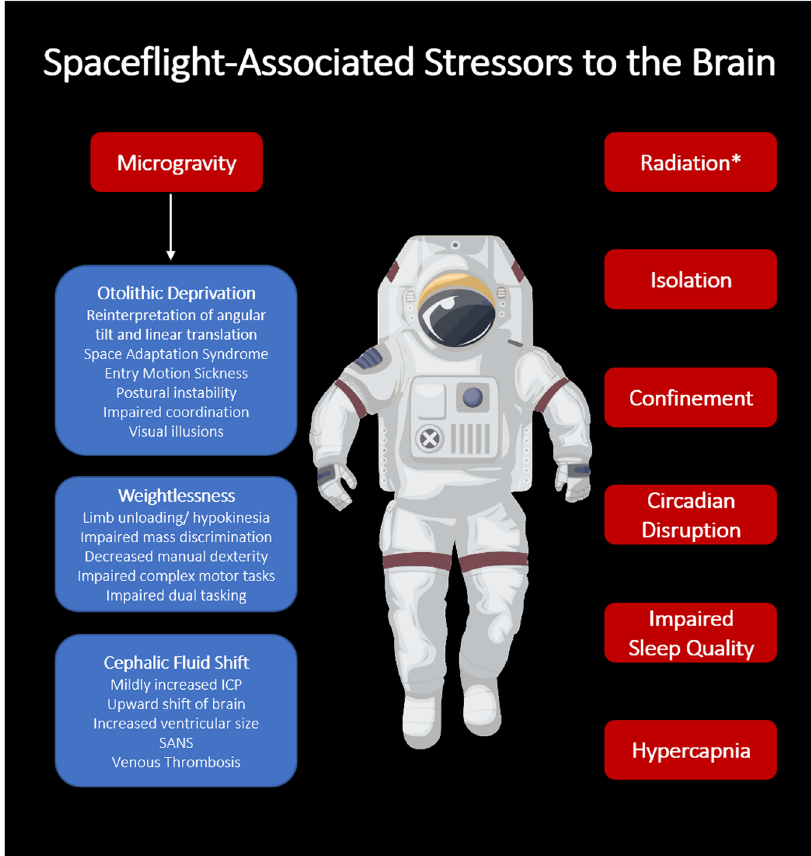
Fig. 1 Summary of environment stressors with potential to impact the brain during space fl ight. ICP = Intracranial Pressure. SANS = Space fl ight-Associated Neuro-Ocular Syndrome. *Radiation in this case refers to Deep Space Radiation, a hypothesized but as of yet unproven risk of deep space exploration, rather than the radiation experienced in Low-Earth Orbit (LEO)